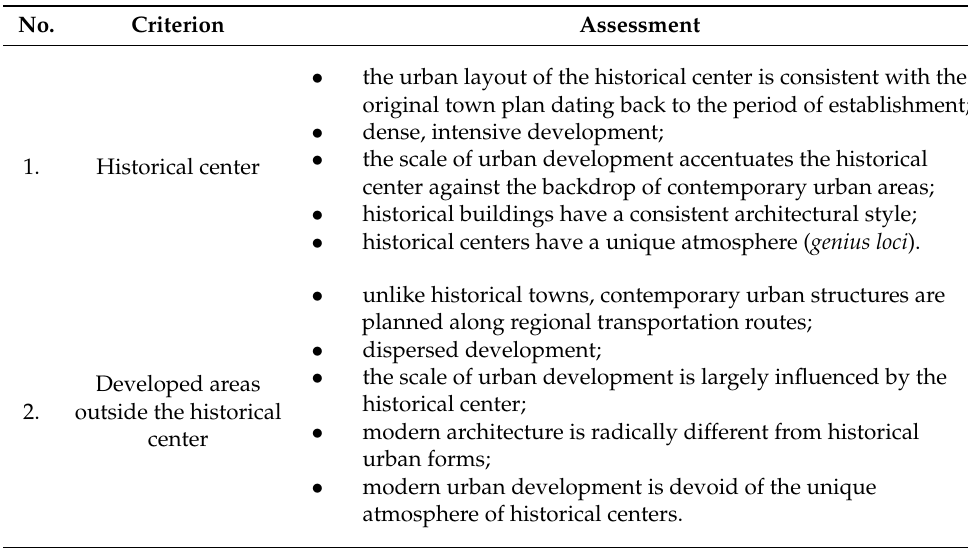
Table 8. Factors responsible for the territorial expansion of the studied